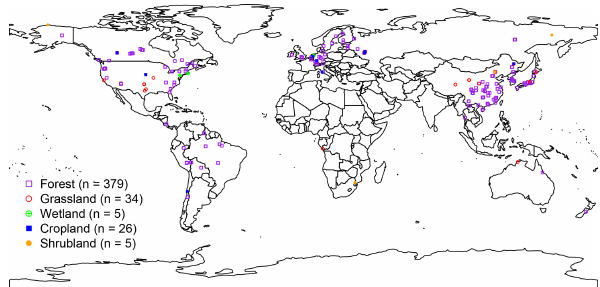
Figure 1. Distribution of observational sites used to develop the globally gridded RF-RA